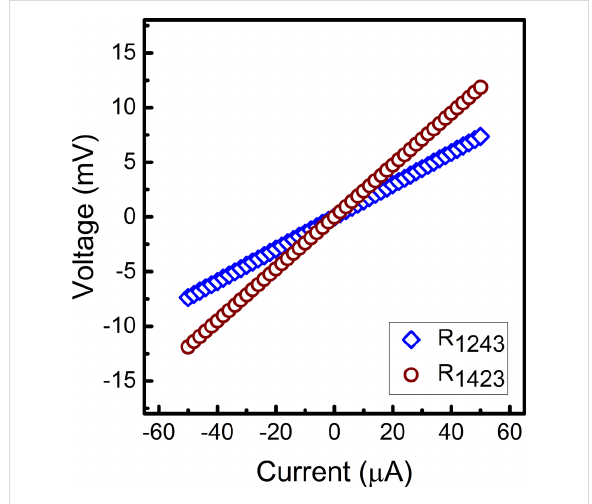
Figure 10: I – V characteristics of vertical graphene nanosheets from four-probe